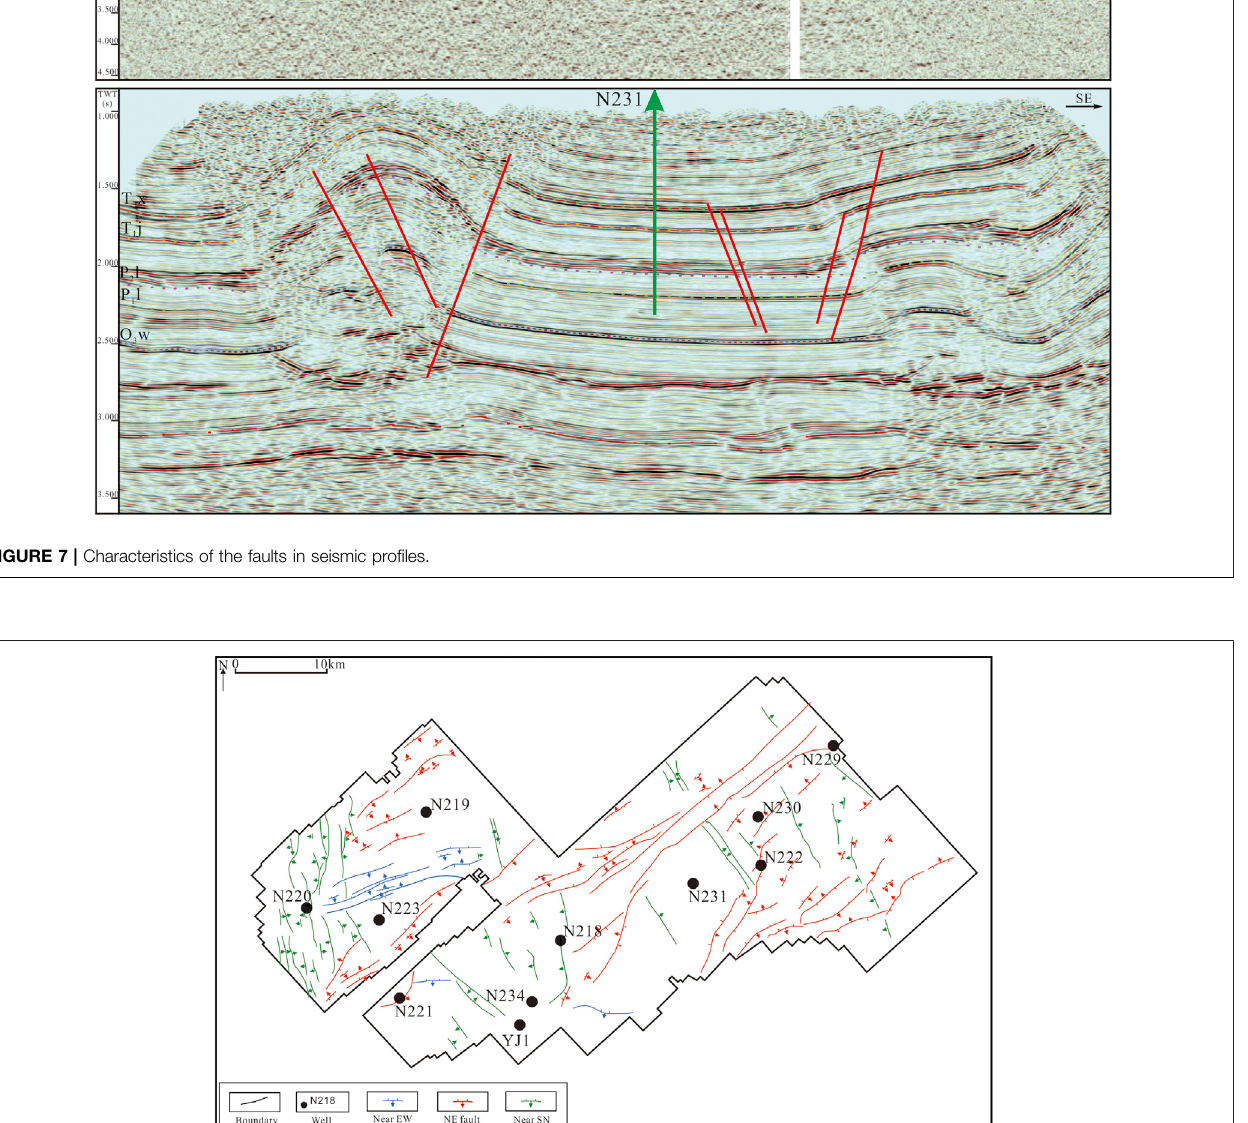
Yanjin – Junlian area.